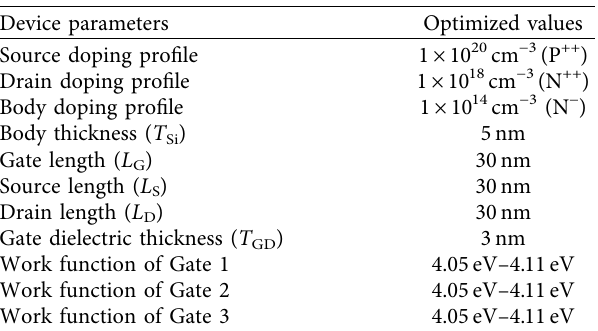
Figure 1: The structure of the N-type Ti-TFET device: (a) three-dimension view (the shaded part is the interface between source and channel, and (b) the cross section along the center of the Y - Z plane of the device. Table 1: Device